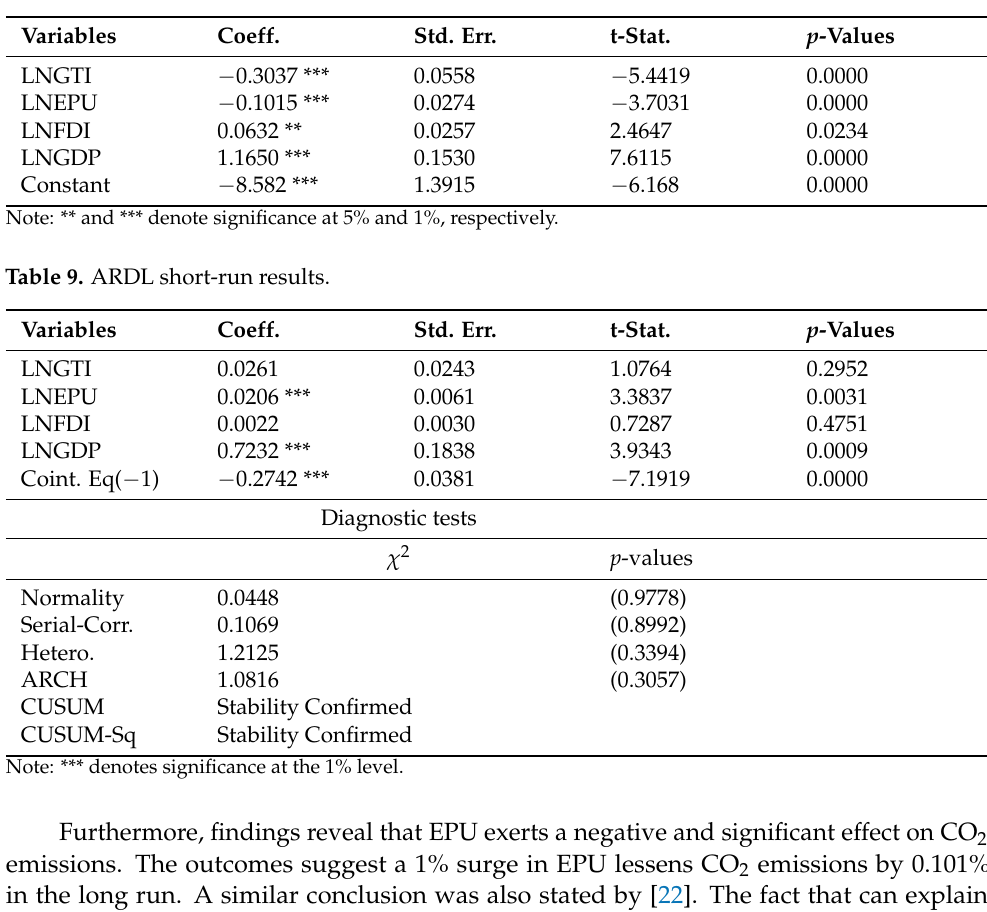
Table 8. ARDL long-run results.